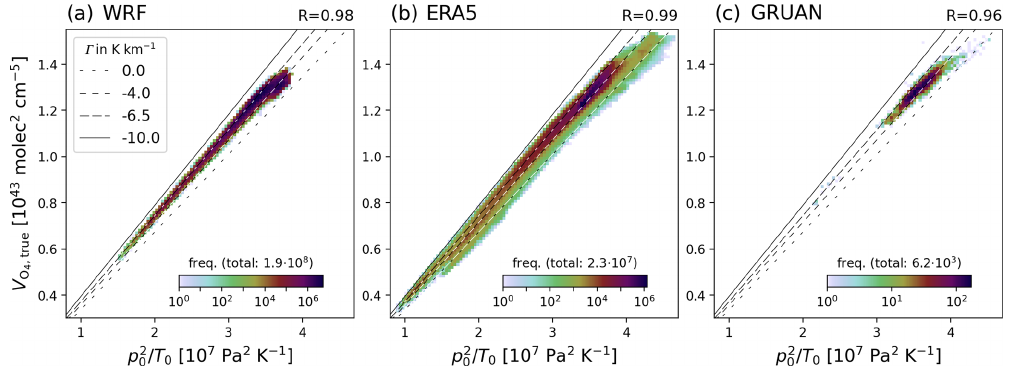
/T 0 for (a) WRF data for May to June 2018 from 07:00 to 17:00UTC, Figure 1. Density plots of the relation between the O 4 VCD and p 2 0 (b) ERA5 data for the 4 selected days in 2018, and (c) all available GRUAN profiles. Frequency per pixel is color coded, with a binning of 100 pixels for both x and y axis, as in all 2D frequency distributions shown below. Respective correlation coefficients are provided in the top right of each panel. Lines display the expected dependency according to Eq. (10) for different lapse rates. Low values correspond to high-altitude sites with low surface pressure; for GRUAN, only few of such stations are available (Boulder and La Réunion at 1.7 and 2.2km altitude, respectively). The very high values for ERA5 and GRUAN are observed for polar regions with cold temperatures.